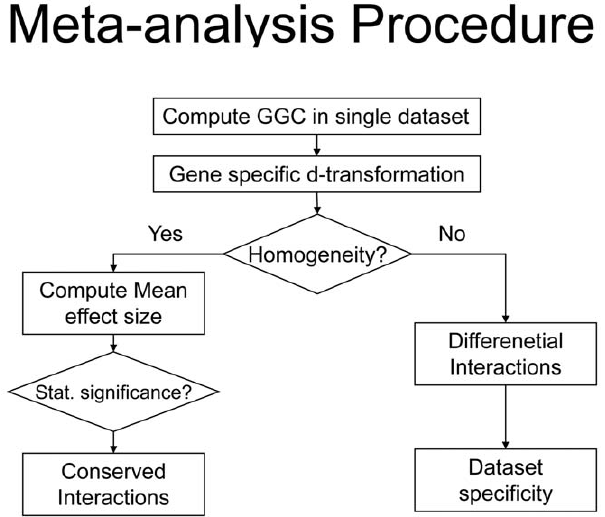
Figure 1. Proposed meta-analysis algorithm flowchart. After calculating all pair-wise gene-gene correlation coefficients (GGC) and transforming them into the proposed d-statistic, the algorithm iterates through every gene-pair one at a time, testing for homogeneity and whether the mean effect size differs significantly from zero.